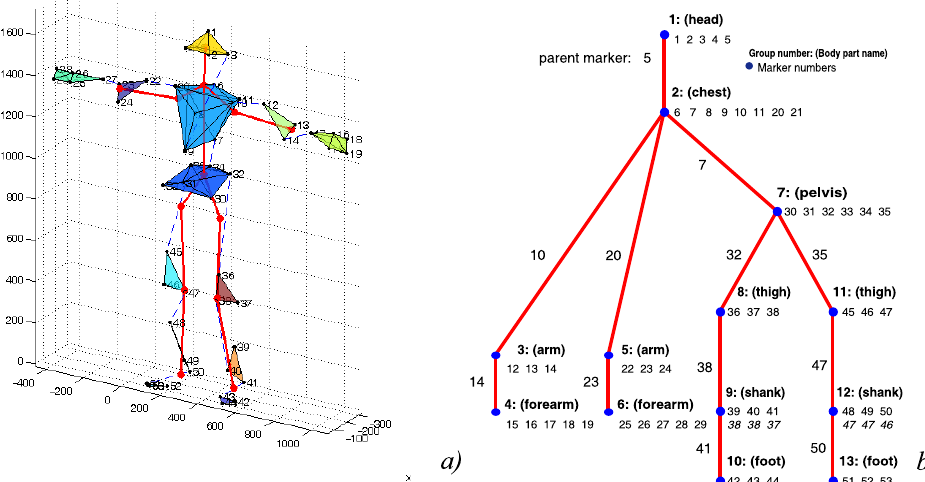
Figure 2. Outline of the body model ( a ), and corresponding parts hierarchy annotated with parents and siblings ( b